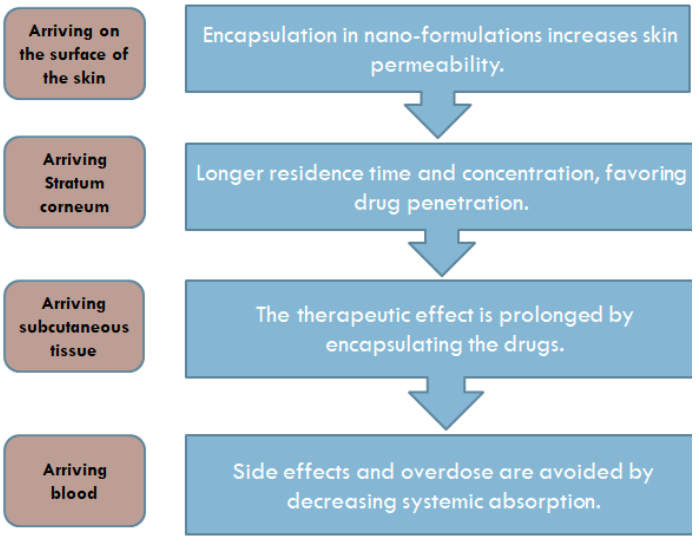
Figure 1. Highlights of the benefits of drug delivery using nano-formulations [13]. Table 1. Summary of typical components, transdermal mechanisms and applications of nano-formulations [13].